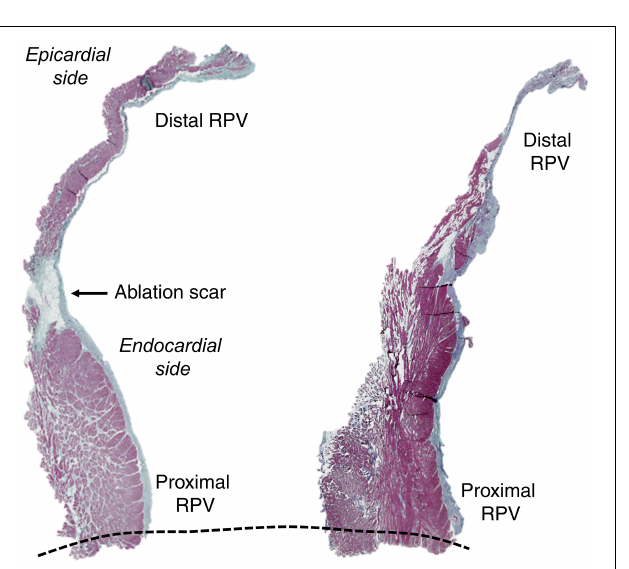
FIGURE 5 | PV histology. Histological preparations of the RPV including the distal PV and the atrial-PV junction (dotted line) with Masson’s trichrome staining (red: cardiomyocytes, black: nuclei, green: collagen). The transmural collagenous scar tissue (arrow) in the left panel is noted. The right panel shows an RPV slice without a scar. The ablation catheter was advanced into the PV under fluoroscopic monitoring (see the position in Figure 1A ).